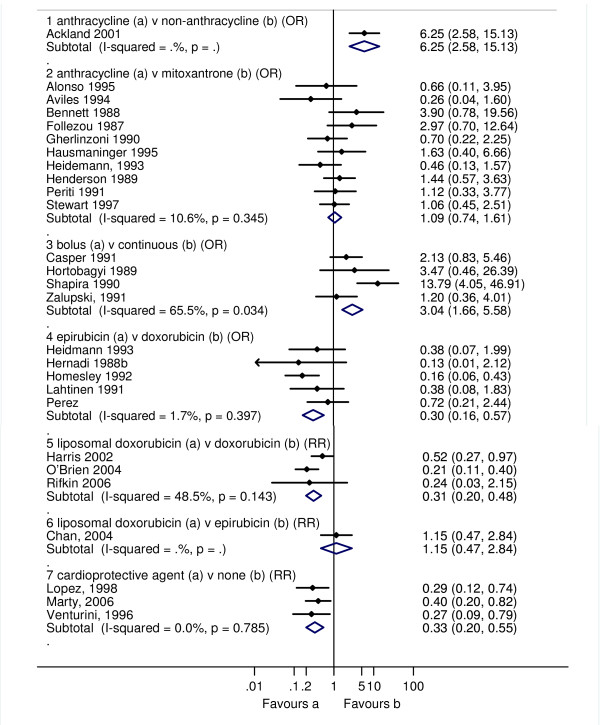
Sub clinical cardiotoxicity defined as reduction LVEF in RCTs comparing different treatment regimens. The open diamond represents the pooled Peto Odds Ratio and 95% CI for treatment comparisons 1-4, and relative risk (RR) with 95% CI for comparisons 5-7. I-squared represents the proportion of variability between studies in excess of that expected due to chance, and p = probability that the differences between study estimates are due to chance.